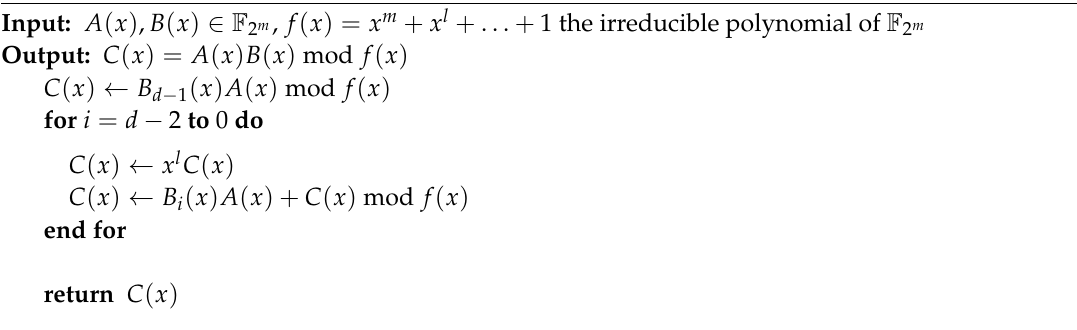
Algorithm 5 Digit Multiplication in F 2 m Where d is the Digit Size [55].